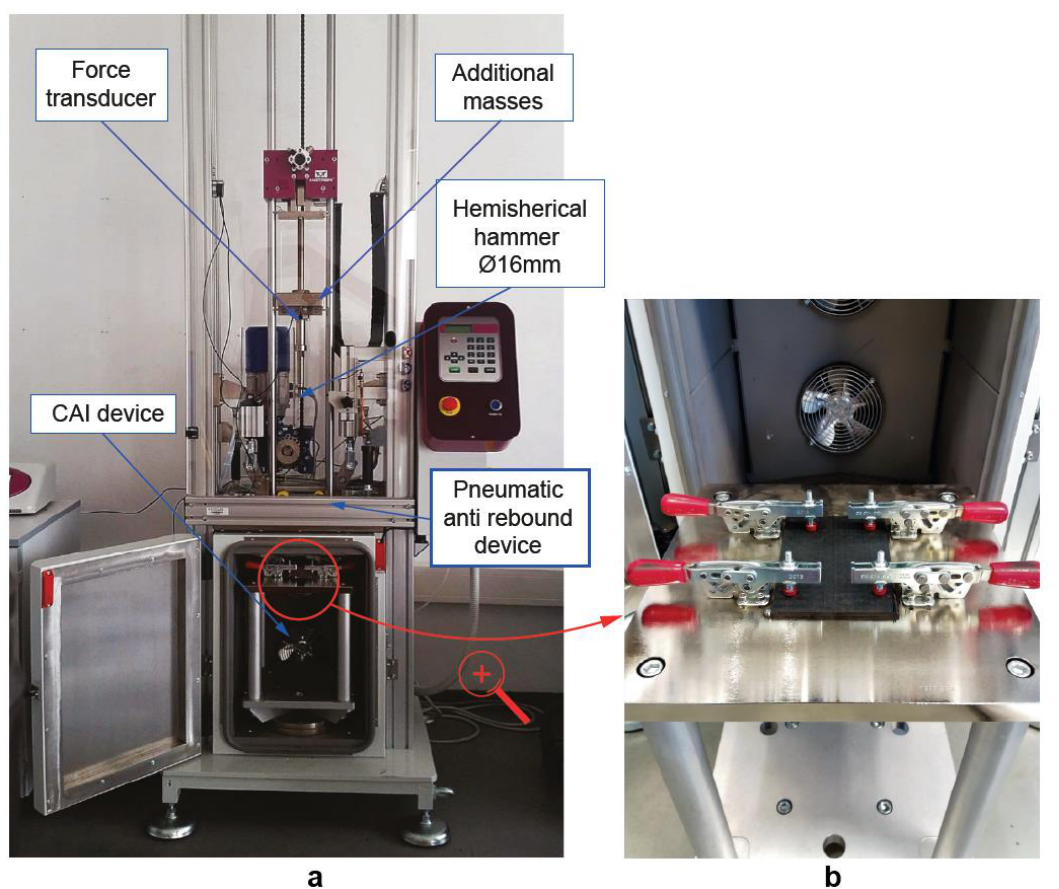
Experimental setup for drop-weight impact test. ( a ) Drop-weight column device. ( b ) Compression after impact (CAI) support fixture according to ASTM D7136 standard.